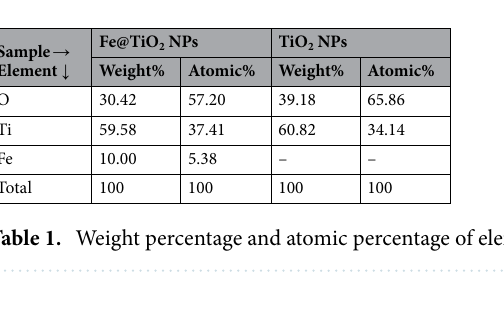
Figure 4. ( a ) EDX of Fe@TiO 2 NPs and ( b ) EDX of TiO 2 NPs.